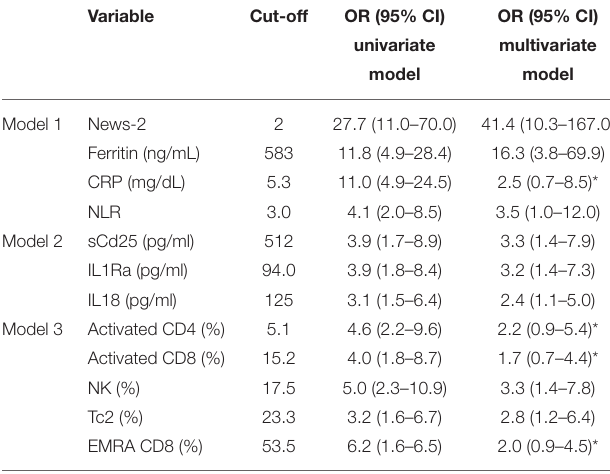
TABLE 2 | Cut-off values and ORs (95% CI) for the risk of developing severe/critical COVID-19 in the univariate and multivariate analyses for News-2, Ferritin, CRP and NLR (model 1), for the cytokines sCD25, IL1Ra and IL18 (model 2) and for activated CD4 and CD8, NK, Tc2 and EMRA CD8 (model 3). Variable Cut-off OR (95% CI) OR (95% CI) univariate multivariate